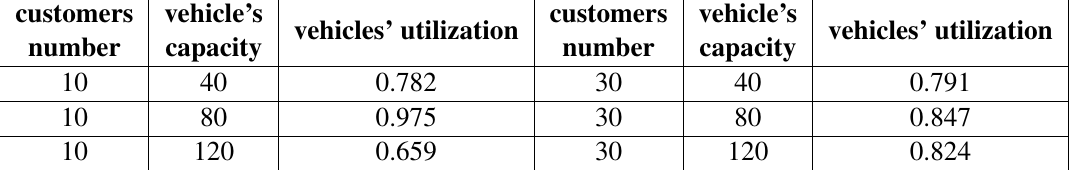
Table 3 Vehicles’ utilization with vehicles capacities